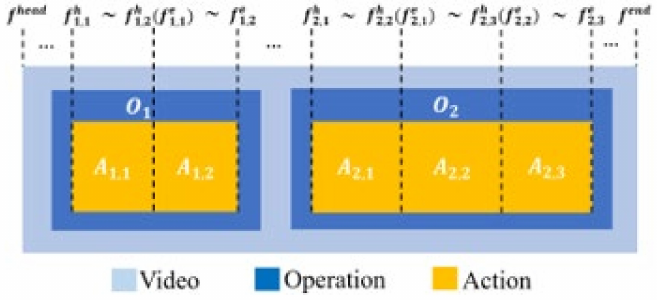
Figure 2. The model of Augmented Reality assisted assembly